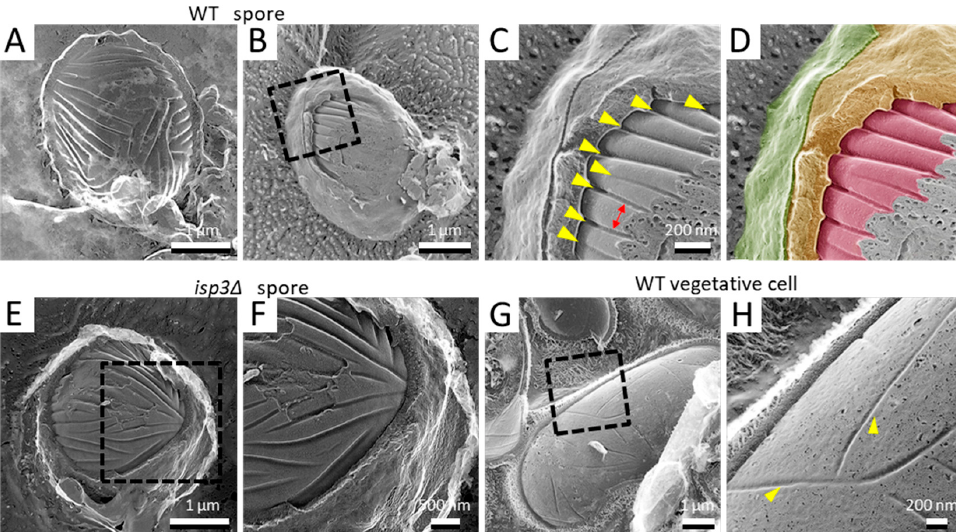
Figure 3. Invagination structure on the membrane surface of spores and vegetative cells. ( A ) Spore with the cell wall detached by fracture. ( B ) Spore with the cell wall and cell membrane partially exposed by fracture. ( C ) Magnified image of the boxed region in B. Yellow arrowheads indicate invaginations of the membrane surface. Arrow indicates the in-terval of the invaginations. ( D ) Colored image of C. The fibrillar layer is colored green, the spore wall yellow, and the spore cell membrane red. ( E ) isp3 Δ spore with a fractured spore wall. ( F ) Magnified image of the boxed region in E. ( G ) Vegetative cell surface with fractured cell walls. ( H ) Magnified image of the boxed region in ( G ). Arrowheads indicate invaginations of the membrane surface.